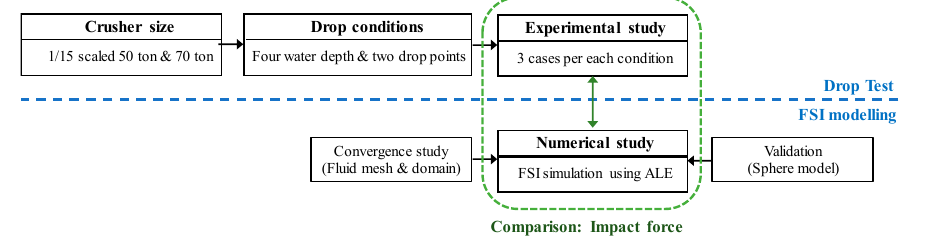
Figure 1. Framework of the present study.